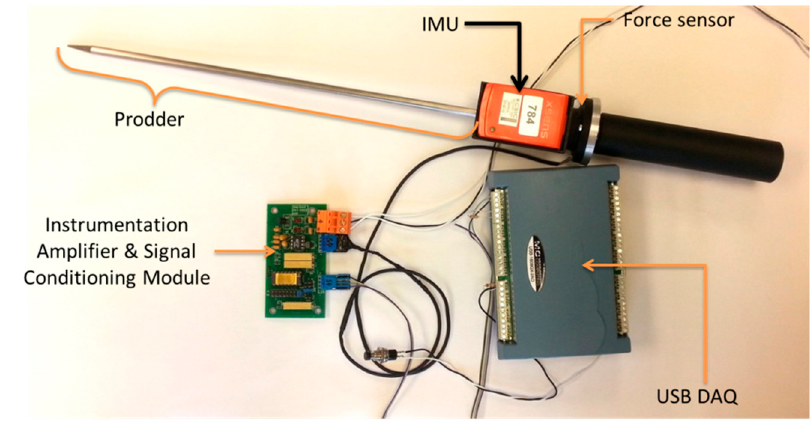
Figure 3. Main components of the proposed tool.